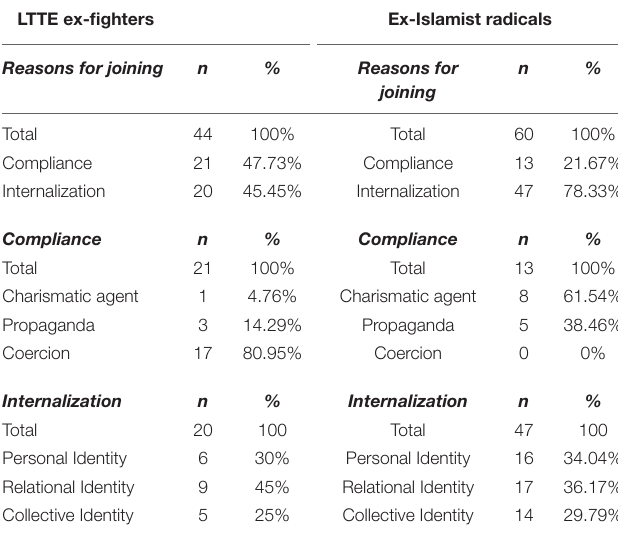
TABLE 1 | Percentage of reasons among total reasons.